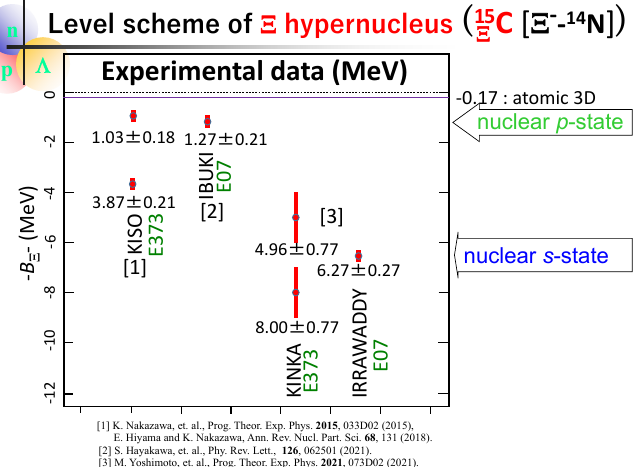
Figure 2. Ξ − and Ξ − nuclear states in 14 N, assigned in KEK-E373 and J-PARC E07 emulsion experiments 1 s 1 p by interpreting Ξ − capture events that lead to observed twin- Λ hypernuclear decays. Figure provided by Dr. K. Nakazawa, based on recent results from Refs.